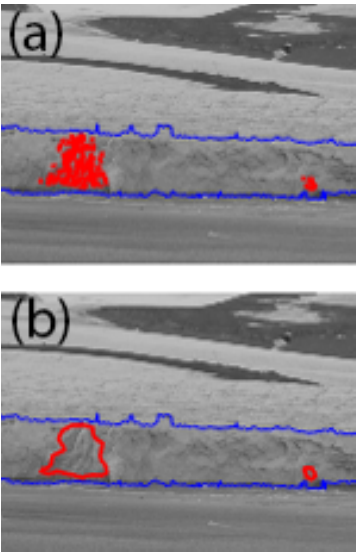
Figure 2. (a) Clustered points at which change has been detected using the method described in Sect. 3.3.2. (b) Mask reconstruc- tion using the method described in Sect. 3.3.3, which transforms the clustered points into polygons.